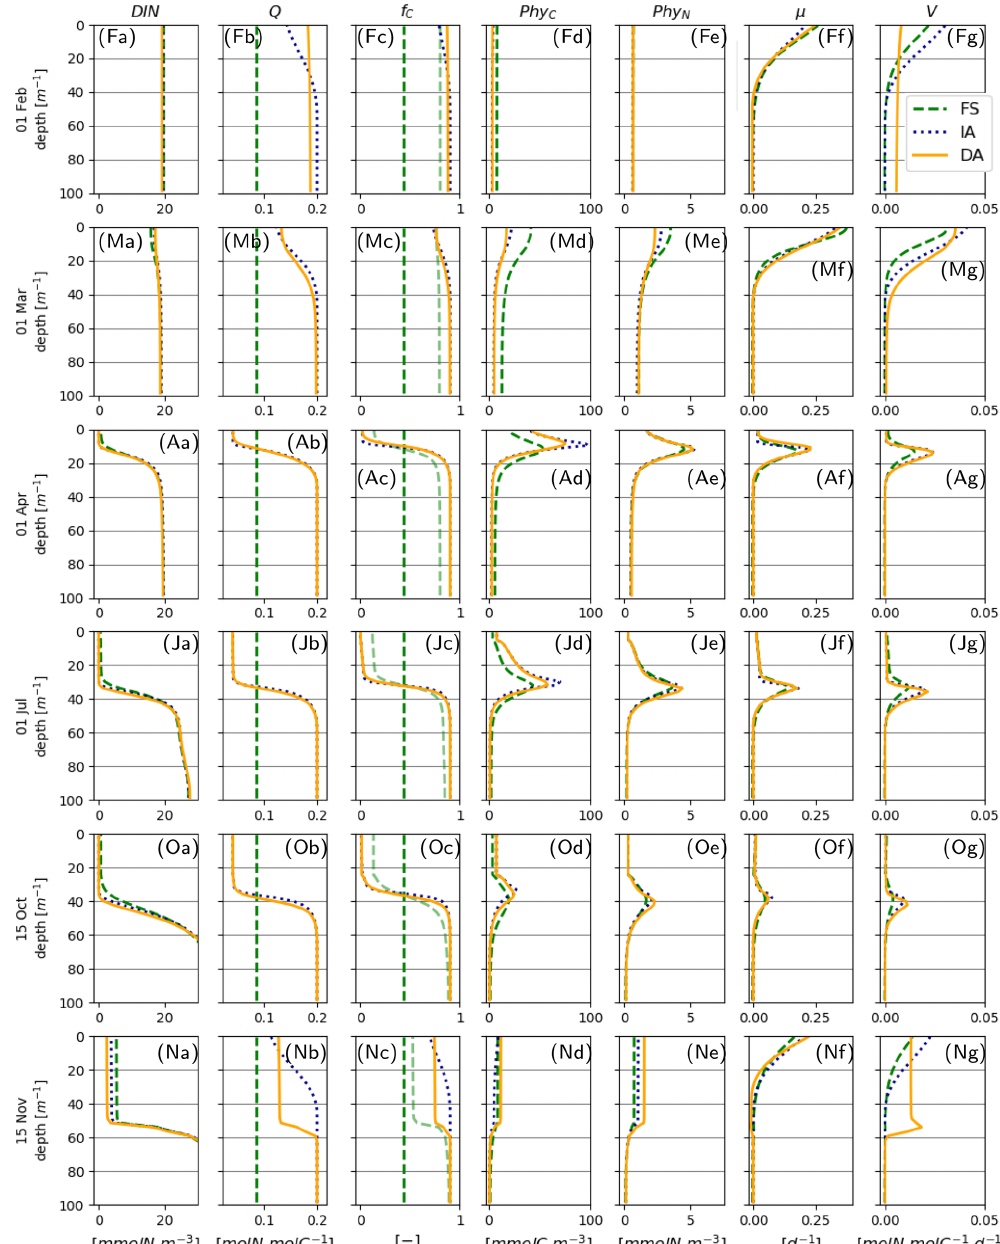
Figure 8. Vertical profiles on 1 February (indicated as F in panel label), March (M), April (A), July (J), and 15 October (O) and November (N) for DIN [mmolNm − 3 ] (a) , phytoplankton Q [mmolNmmolC − 1 ] (b) , f C [–] (c) , Phy C [mmolCm − 3 ] (d) , Phy N [mmolNm − 3 ] (e) , µ [d − 1 ] (f) , and V [molNmolN − 1 d − 1 ] (g) as simulated by the IA (fine-dashed dark blue line), DA (continuous orange line) and the FS (dashed green line) variants, when the prescribed (cid:50) (Table 3) is scaled with f C , according to Eq. (24).